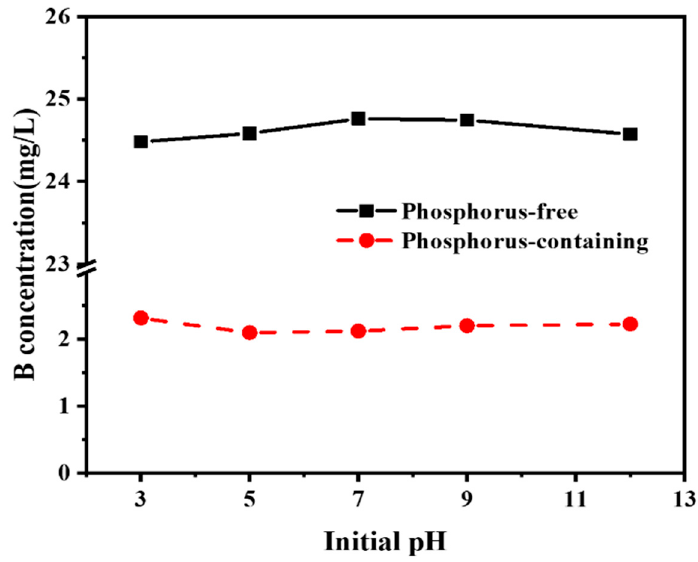
Figure 1. The performance of B removal by calcined oyster shells (COS) singly and in combination with phosphorus (P).